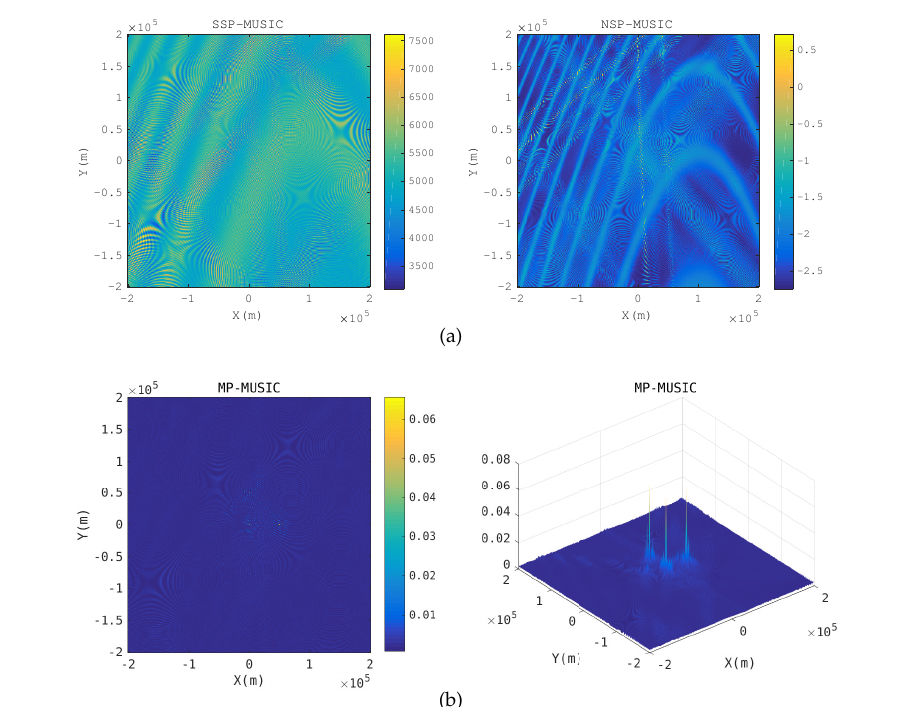
Figure 6. Spatial spectrum when a transponder is close to the anther. ( a ) Spatial spectrum of SSP-MUSIC and NSP-MUSIC ( b ) Spatial spectrum of MP-MUSIC.